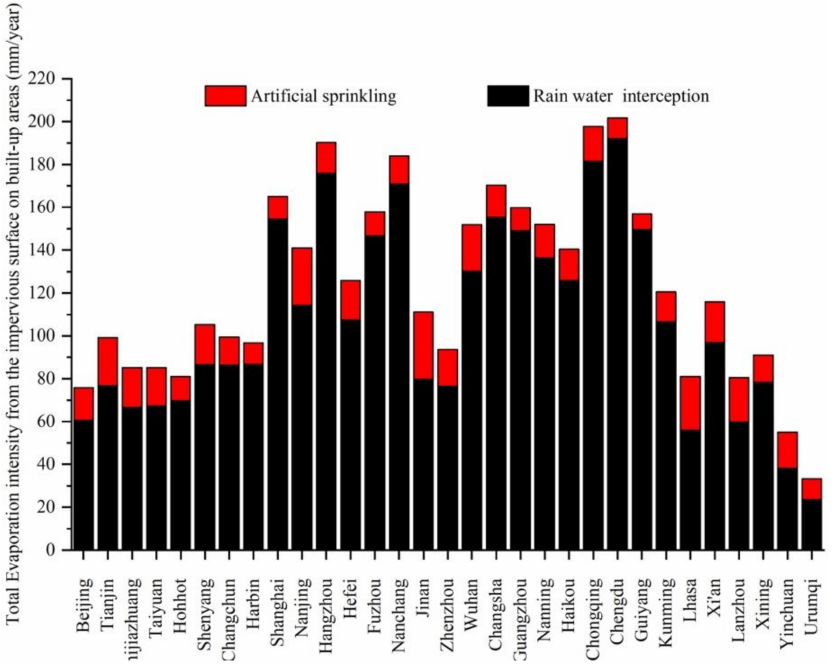
Figure 6. Total evaporation intensity from the impervious hardened surfaces on the built-up area in each capital